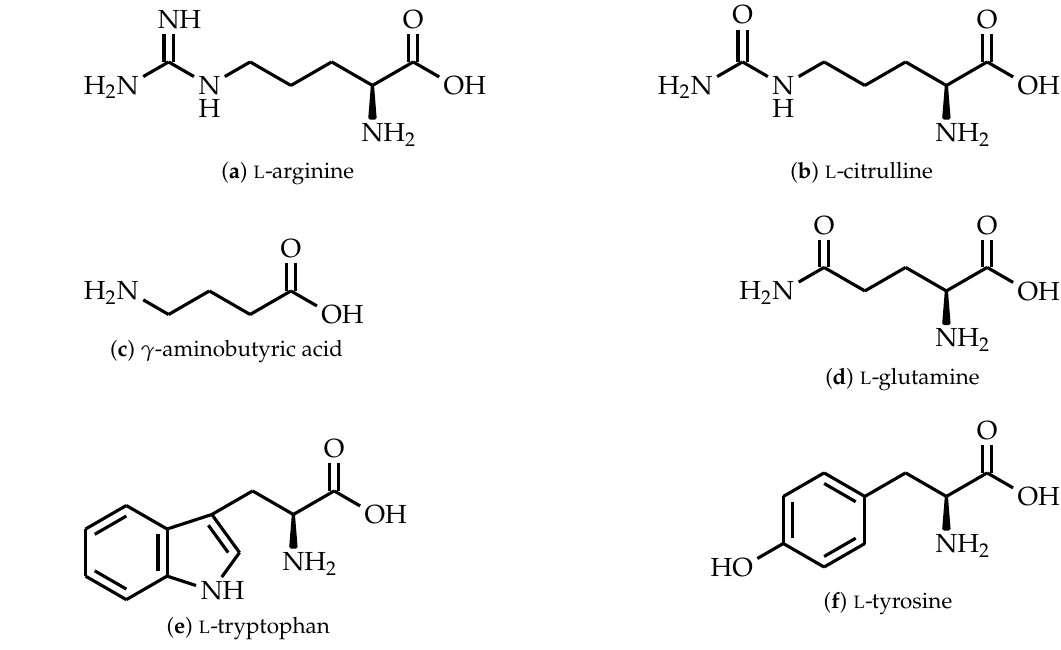
Figure 2. Chemical structures of amino acids used as curing